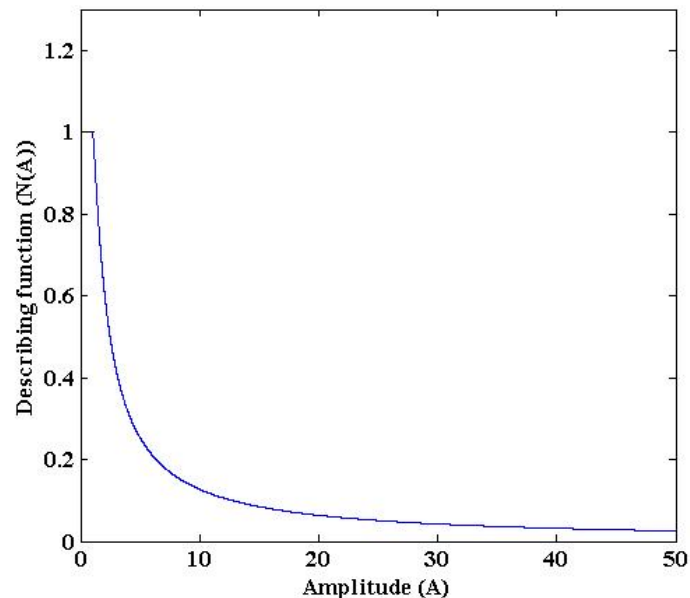
Figure 4. Saturation nonlinearity representation using the describing function N ( A ).